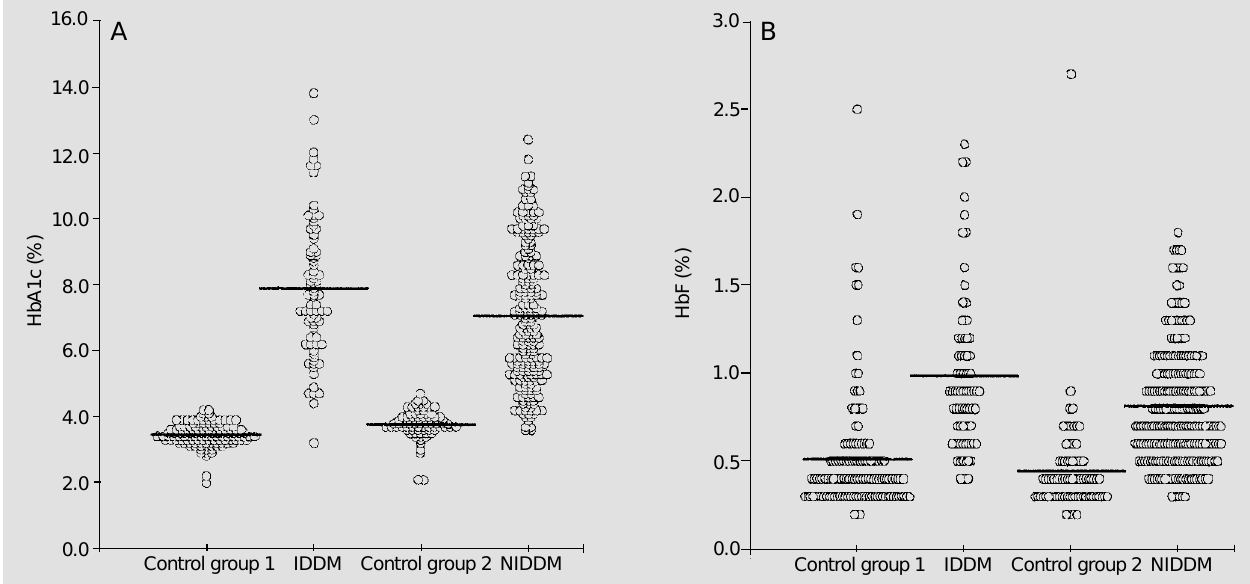
Figure 1 - HbA1c (A) and HbF (B) levels in IDDM (type 1 diabetes) and NIDDM (type 2 diabetes) subjects and in their respective control groups. Solid lines denote